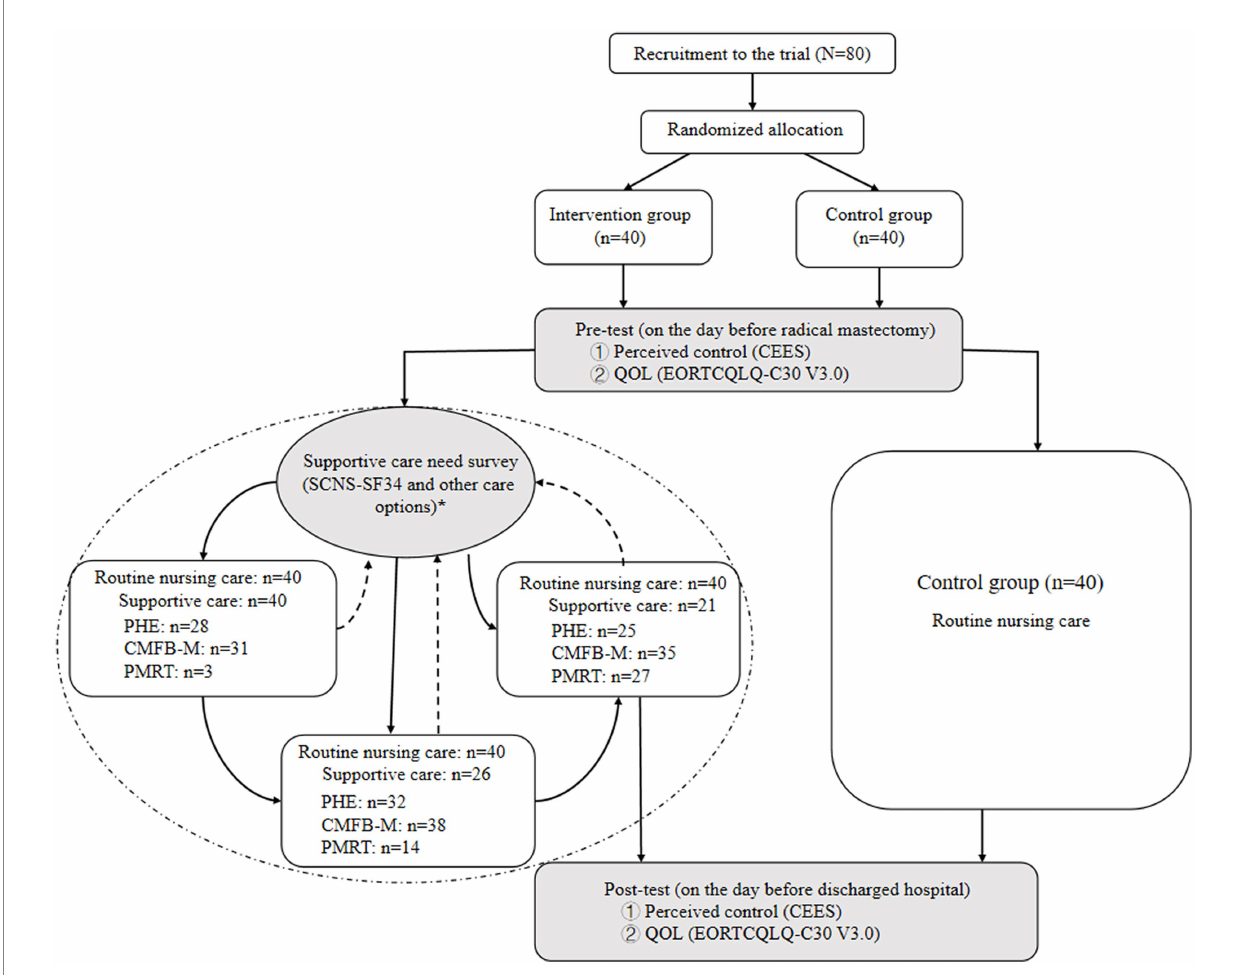
FIGURE 1 Flow chart of the personalized care program for patients with BC PHE: Psychological health education (afternoon 4 p.m.–6 p.m.Once every 3 days for 1 h) CMFB-M: Chinese medicine foot bath combined with massage (evening 21–22:30 for 30 min) PMRT: Progressive muscle relaxation training (early morning 8 a.m.–10 a.m for 30